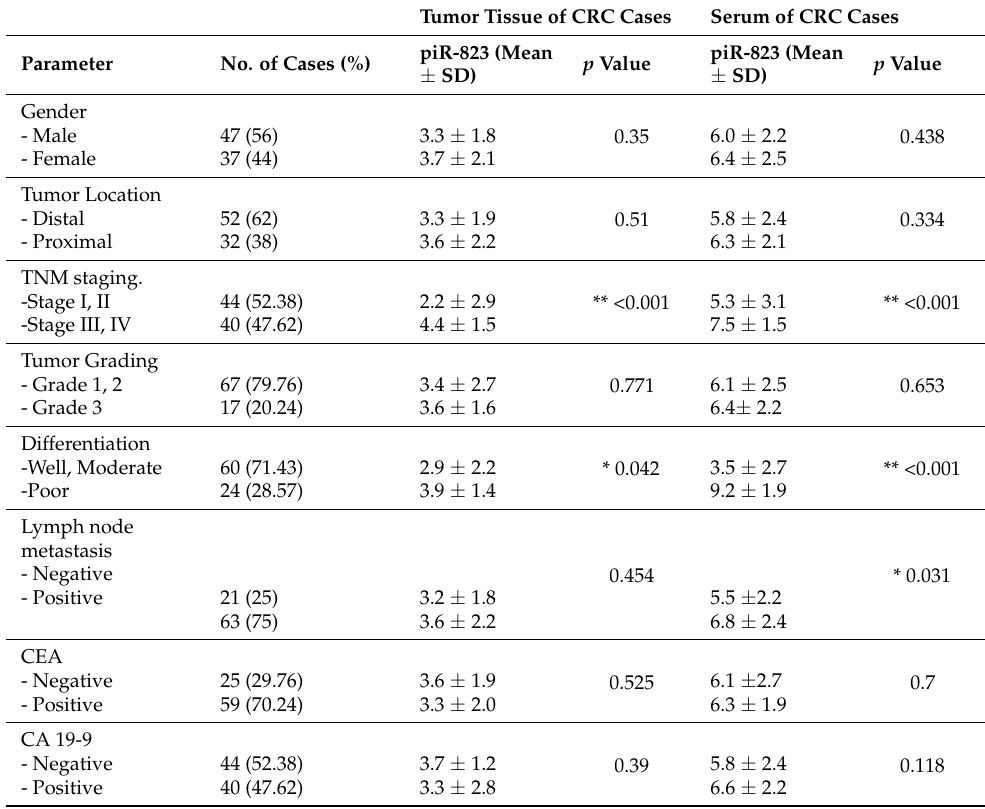
Table 3. Association between piR-823 expression and clinicopathological characteristics in colorectal cancer